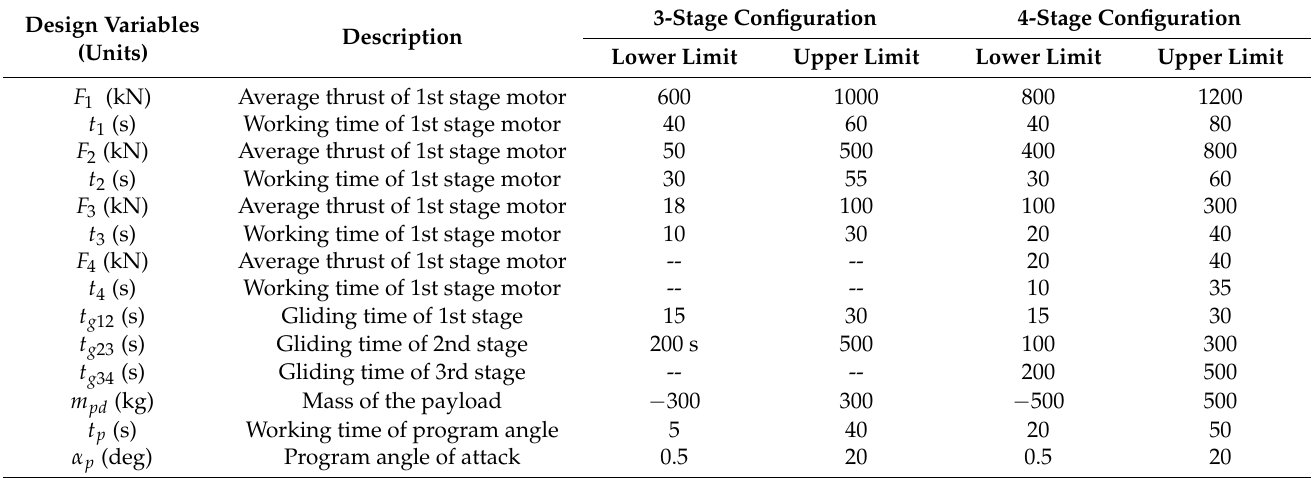
Table 2. Boundaries of optimal design variables for overall